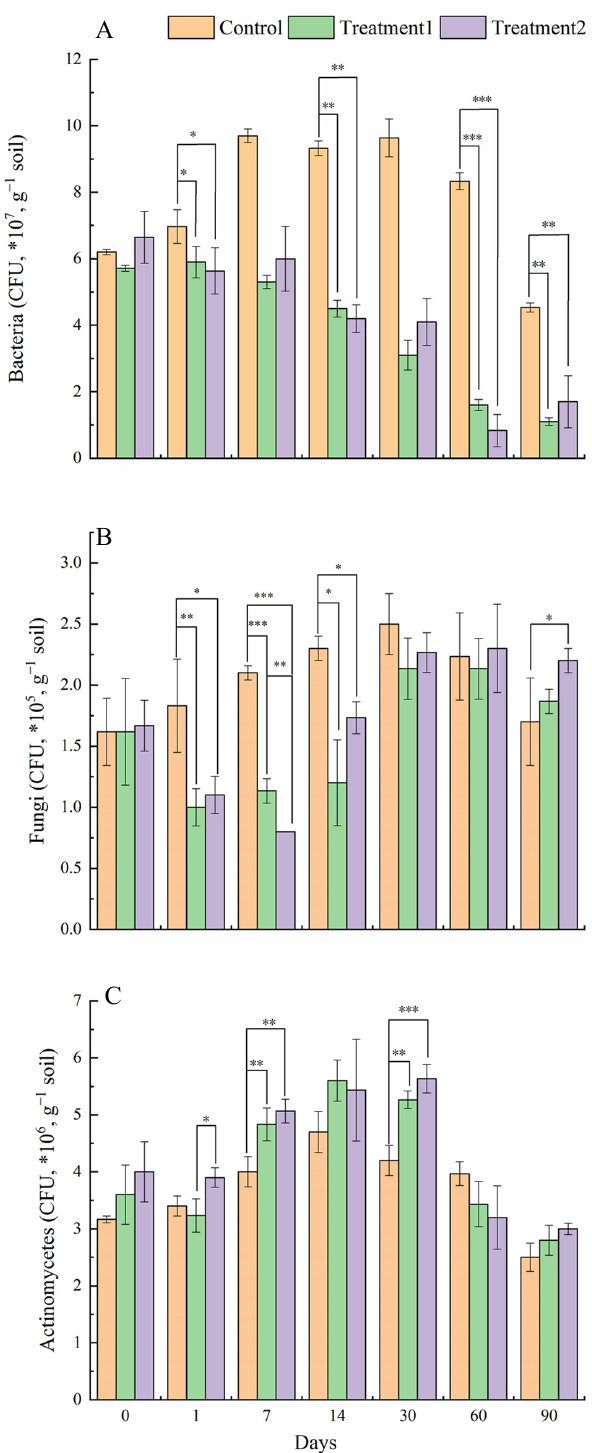
Figure 3. Effect of fomesafen on the biomass of bacteria, fungi, and actinomycetes in soil in the recommended usage and the twice recommended usage groups. Data represent the mean ± SD of each soil sample selected at each time point. *, ** and *** represent the significance levels of 0.05, 0.01 and 0.001, respectively; without * indicates that the difference is not significant according to UNIANOVA with Duncan’s homogeneity test. Treatment 1 represents the recommended usage group, and Treatment 2 represents the twice the recommended usage group. ( A ) Bacteria; ( B ) fungi; ( C ) actinomycetes.